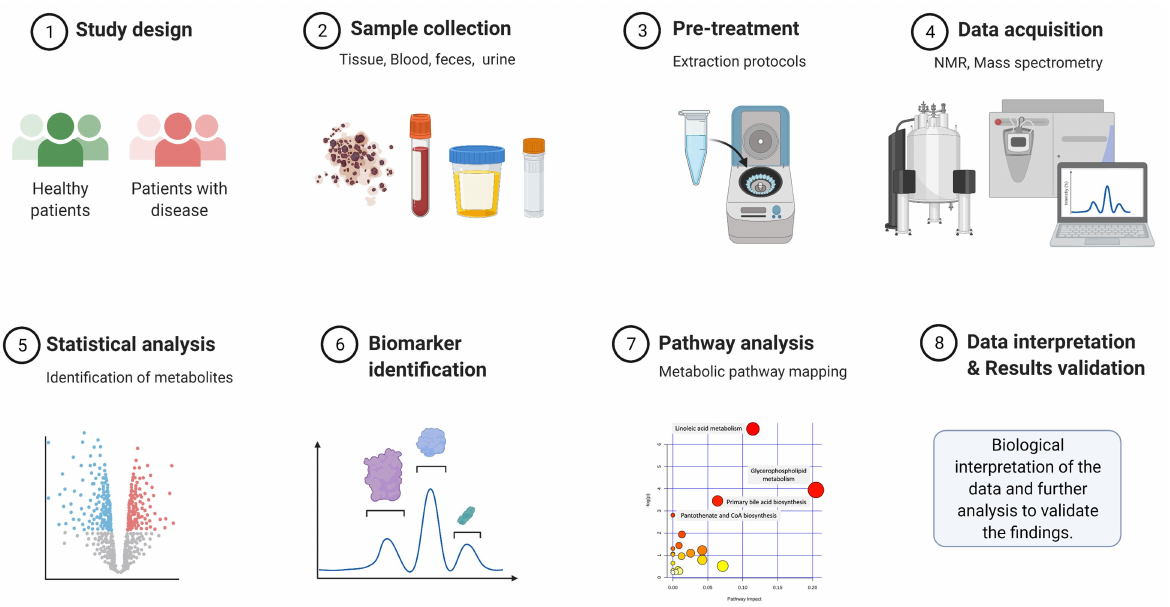
Figure 3. A standard workflow for untargeted metabolomics. After sample collection and extraction, the samples are analyzed by NMR spectroscopy or mass spectrometry. The raw data are then analyzed using appropriate software followed by statistical analysis to identify metabolites of interest or potential candidate biomarkers. Adapted from “Untargeted Metabolomics for Discovery of Disease Biomarkers”, by BioRender.com (2021). Retrieved from https://app.biorender.com/ biorender-templates on 11 August